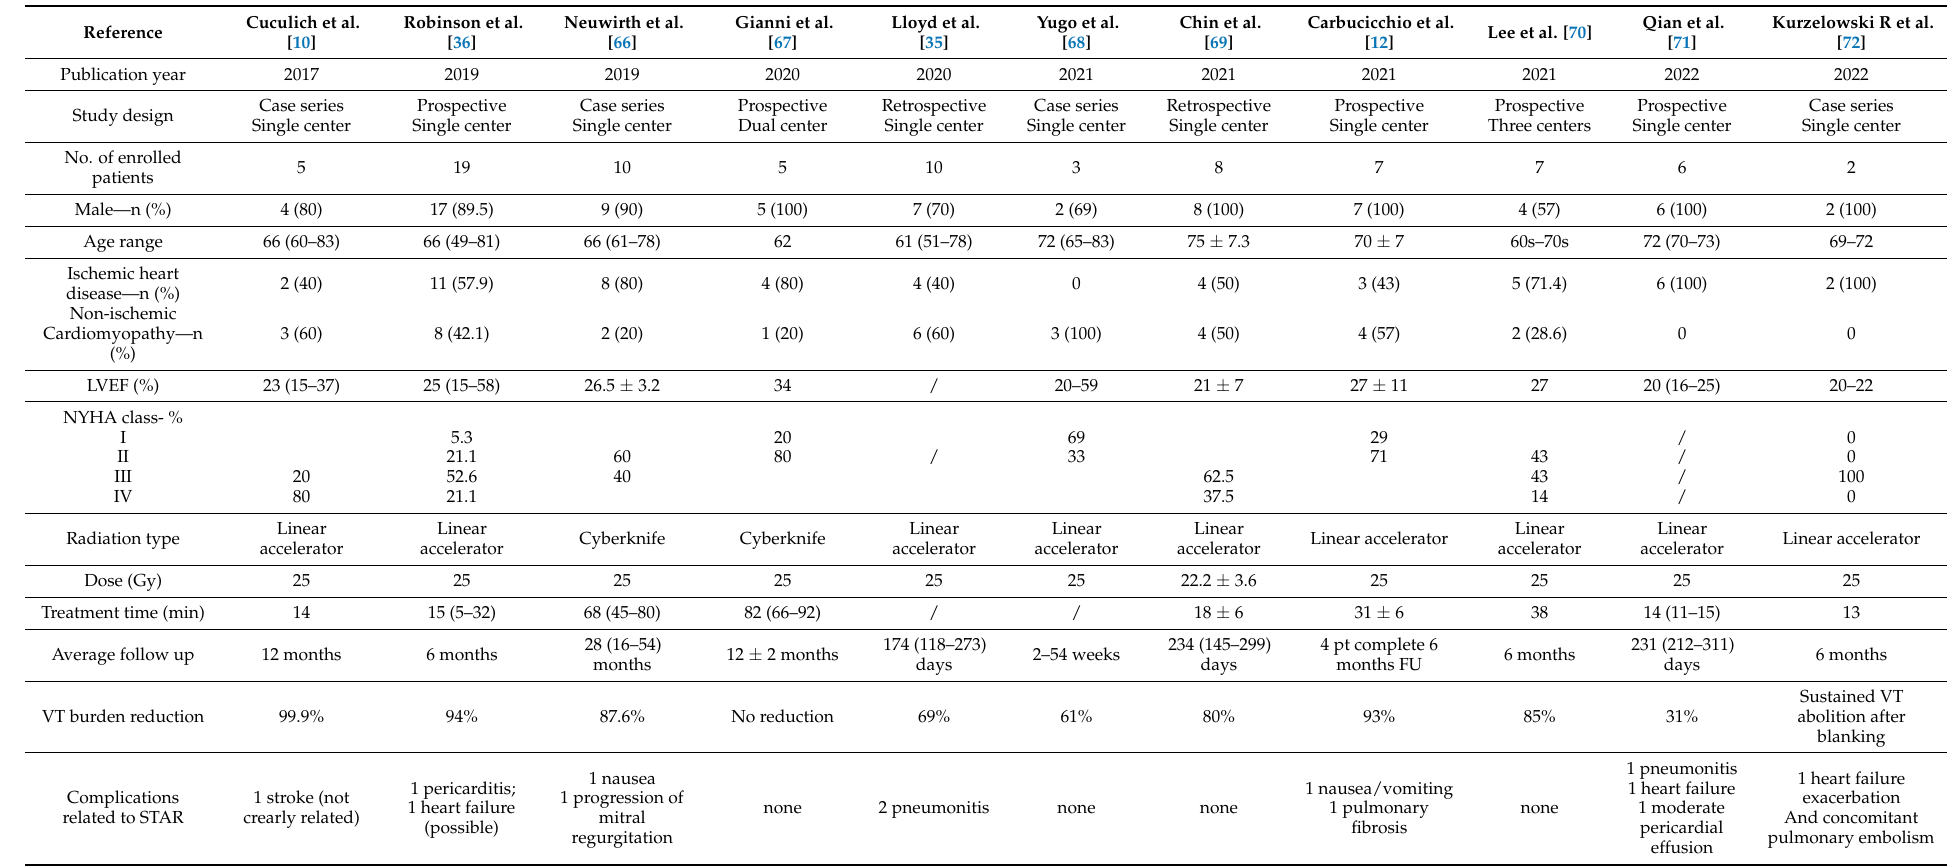
Table 3. Summary of main studies on STAR. LVEF (left ventricular ejection fraction), NYHA (New York Heart Association), VT (ventricular tachycardia), STAR (Stereotactic arrhythmia